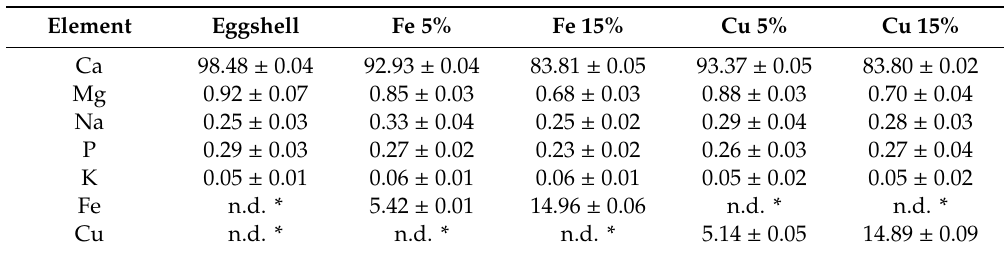
Table 2. Chemical composition in weight percentage of the calcined eggshell and the iron and copper supported nanomaterials measured by